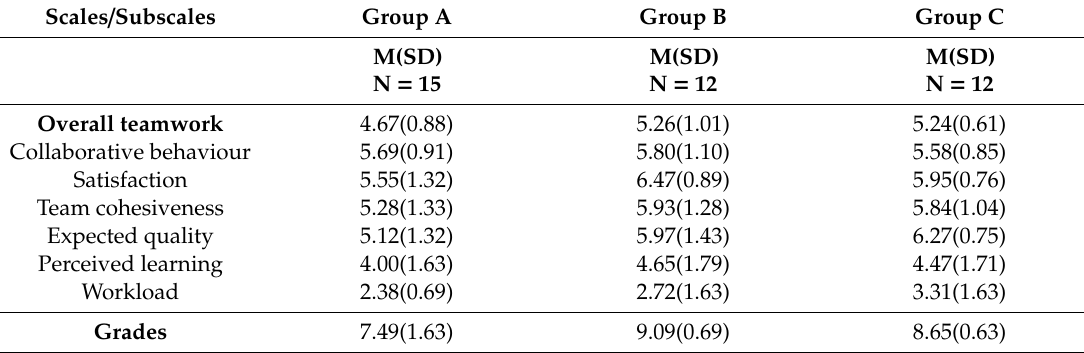
Table 2. Teamwork means and standard deviations by group